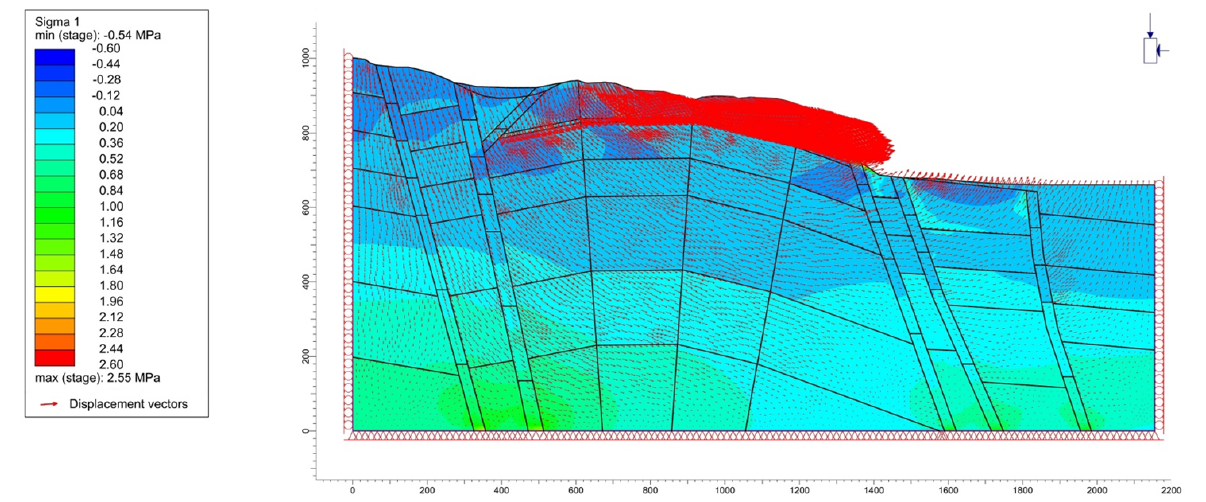
Figure 9. Sigma 1 and displacement vectors during the last tectonic unloading (30,000 ya). x -axis is in meters, while y -axis is in meters a.s.l.